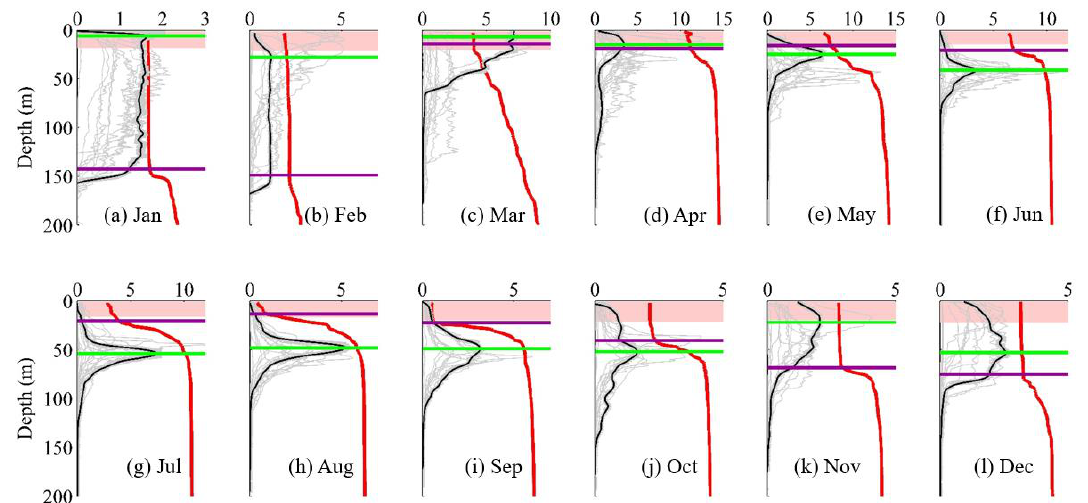
Figure 4. Fluorescence profiles obtained at SATS oceanographic station from January to December. All profiles taken from January 1998 (beginning of the use of CTD equipped with fluorescence sensor) to December 2018 are included and plotted in the corresponding month (grey thin profiles). Randomly, for each month, one profile is highlighted (black profile), also showing its corresponding 5 m low-pass filter profile (thick grey) and the depth at which fluorescence shows its maximum value on this filtered profile (green line). For these randomly selected fluorescence profiles, their corresponding density profiles are also shown (red line) as well as the estimated MLD (purple horizontal line). The x-axis only shows the fluorescence scale (density profiles were re-scaled to be shown on this scale since the interest is the upper ocean vertical structure, which is observable just from density profiles topology). Note that the x-axis is not the same for the di ff erent subplots. The pink shadow area in each subplot shows the depth range integrated by satellite measurements (1 / 5 of the euphotic zone calculated as the depth at which 1% of the PAR at the surface penetrates